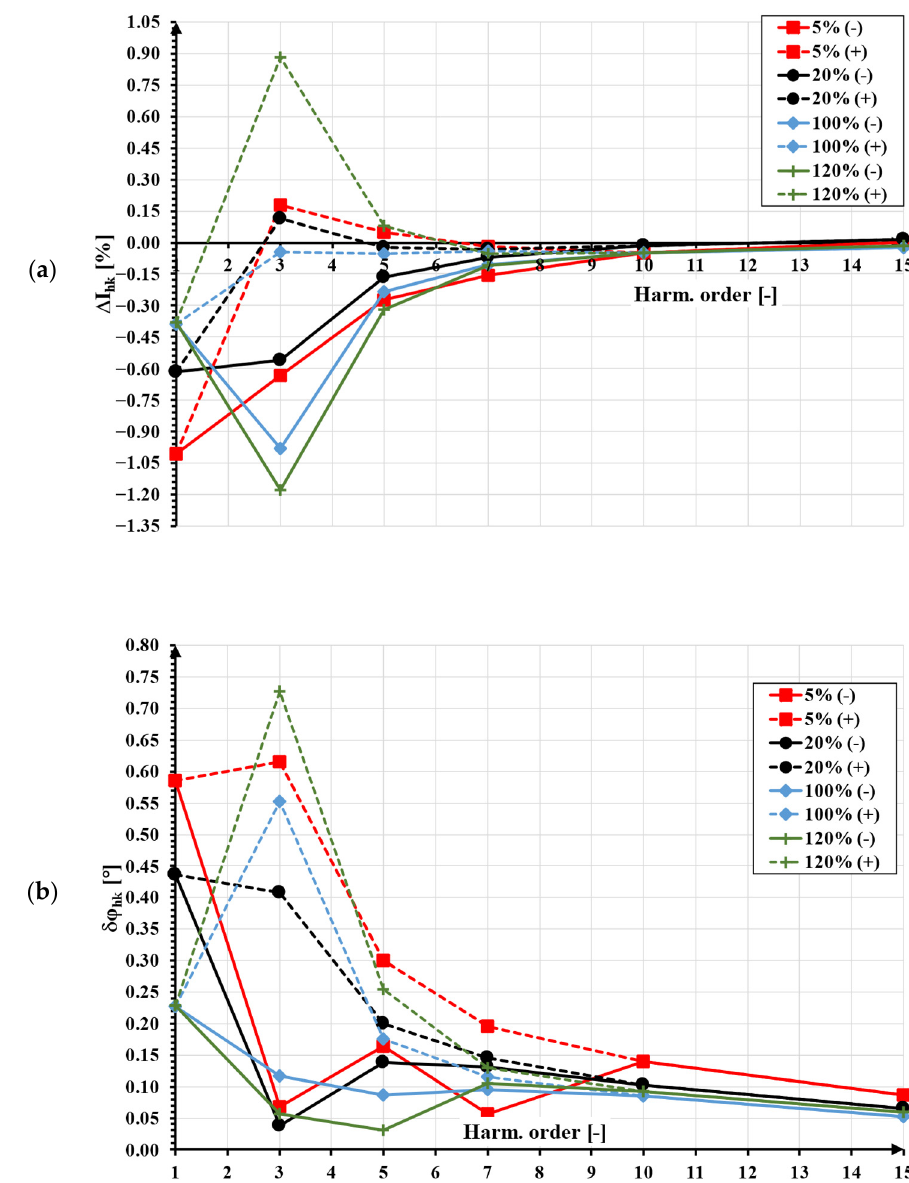
Figure 4. The most positive (+) and the most negative ( − ) values of ( a ) current error and ( b ) phase displacement determined for inductive CT 300 A/5 A with the rated resistive load of the secondary winding [4].